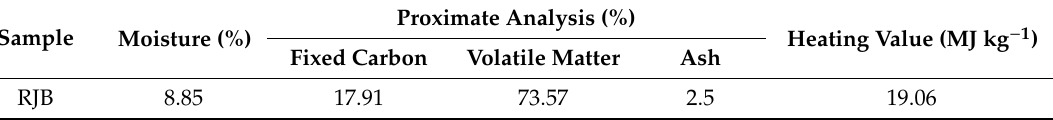
Table 1. The physical and chemical properties of red jujube branch